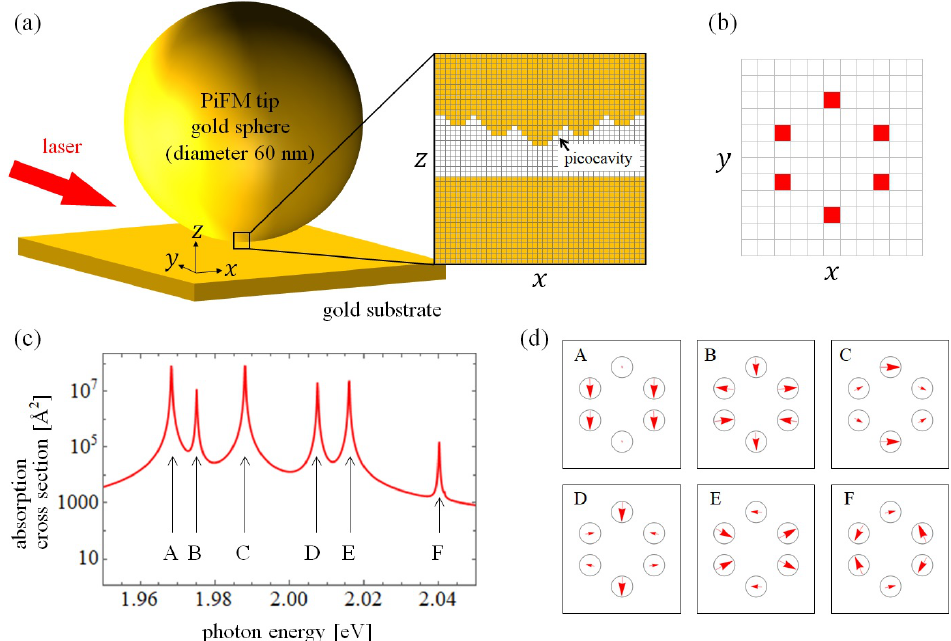
Figure 1. ( a ) Schematic PiFM model. The tip has atomic-scale structures, which form a picocavity on its apex. ( b ) Simplified model of a six-membered ring molecule on the substrate. The susceptibility of each element of the molecule was defined using the Lorentz model. The entire space was dis- cretized into 1 Å 3 cubic cells represented by grid lines. ( c ) Absorption spectrum of a six-membered ring molecule in vacuum. The peaks correspond to the resonance states under long-wavelength approximation. ( d ) The spatial structures of the dipoles in the molecule at each resonance energy, as shown in ( c